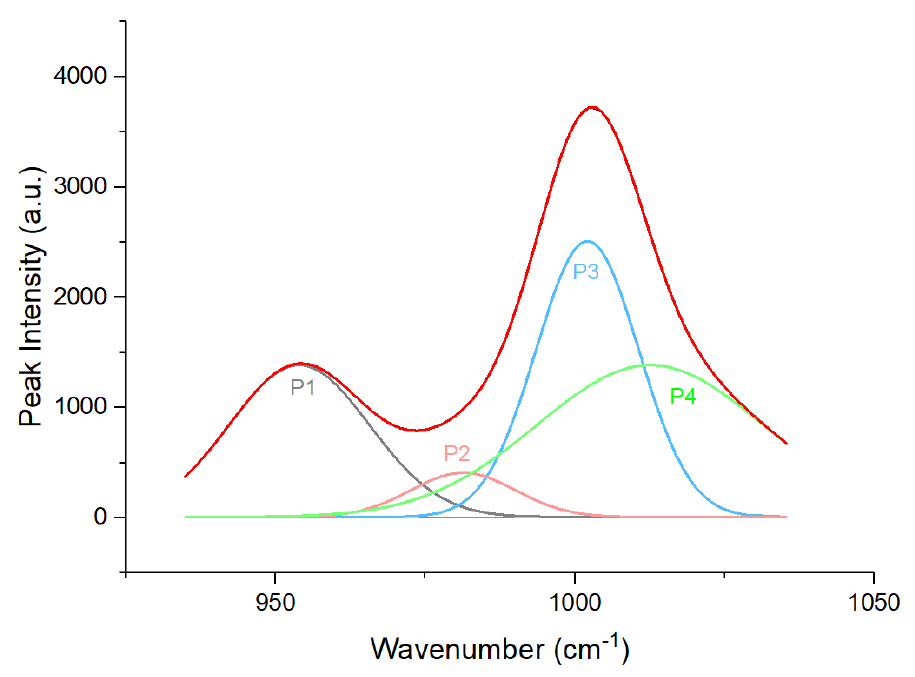
Figure 3. Deconvolution results of Area 1 (920 to 1040 cm −1 ) with P1 (1st peak), P2 (2nd peak), P3 (3rd peak) and P4 (4th peak).